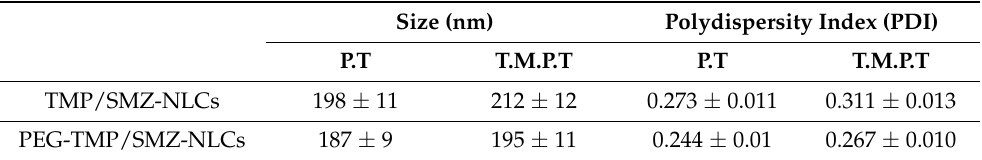
Table 4. Size and polydispersity index (PDI) for TMP/SMZ-NLCs and PEG-TMP/SMZ-NLCs on the production time (P.T) and three months after the preparation (T.M.P.T). Size (nm) Polydispersity Index